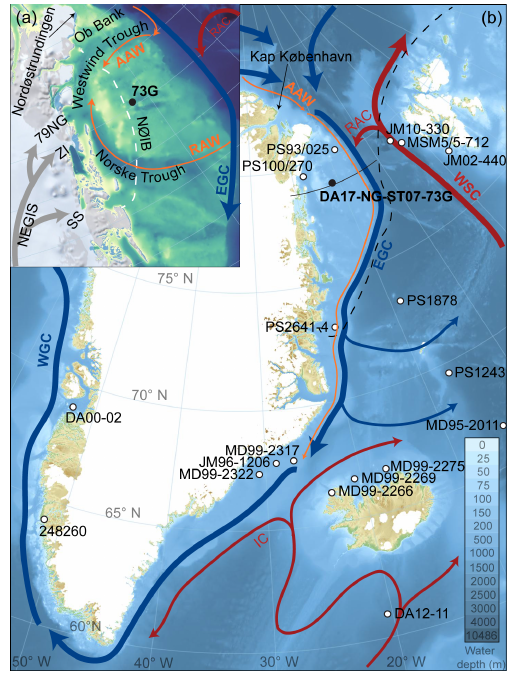
Figure 1. (a) Close-up image of the Northeast Greenland shelf showing its characteristic features, the location of the studied sed- iment core (black circle), and the schematic subsurface circula- tion of the continental shelf (orange arrows). Arctic Atlantic Wa- ter (AAW), Return Atlantic Water (RAW), Nioghalvfjerdsfjorden Glacier (79NG), Zachariæ Isstrøm (ZI), Storstrømmen (SS), the Northeast Greenland Ice Stream (NEGIS, grey arrows), and the Norske Øer Ice Barrier (NØIB; dashed white line) are all labelled. (b) Overview map of the study area with the studied sediment core DA17-NG-ST07-73G (black circle; Rumohr core DA17-NG-ST07- 72R was taken from the same site), other core sites mentioned in the text (open circles), and schematic illustration of the major cur- rents shown. The East Greenland Current (EGC), West Spitsbergen Current (WSC), Return Atlantic Current (RAC), Irminger Current (IC), and West Greenland Current (WGC) are all labelled. Red ar- rows show warm surface currents, blue arrows show cold surface currents, and the orange arrow shows cooled Atlantic-originated subsurface-water mass, i.e. Arctic Atlantic Water (AAW). The following core sites are also labelled: PS93/025 (Syring et al., 2020a; Zehnich et al., 2020), PS100/270 (Syring et al., 2020b), JM10-330 (Consolaro et al., 2018), MSM5/5-712 (Müller et al., 2012; Werner et al., 2013), JM02-440 (´Slubowska-Woldengen et al., 2007), PS1878 (Telesinski et al., 2014a, b), PS2641-4 (Müller et al., 2012; Perner et al., 2015; Kolling et al., 2017), PS1243 (Bauch et al., 2001), DA00-02 (Seidenkrantz et al., 2008), MD99- 2317 (Jennings et al., 2011), JM96-1206 (Jennings et al., 2002; Perner et al., 2016), MD99-2322 (Jennings et al., 2011), MD99- 2275 (Ran et al., 2006), MD95-2011 (Giraudeau et al., 2010), MD99-2269 (Giraudeau et al., 2004, 2010), MD99-2266 (Moossen et al., 2015), 248260 (Seidenkrantz et al., 2007), and DA12-11/2 (Van Nieuwenhove et al., 2018; Orme et al., 2018). The black line shows the location of the hydrographic transect pictured in Fig. 2b. The dashed black line shows the median sea-ice extent in September (1981–2010). The ocean bathymetry data are derived from GEBCO (Weatherall et al.,